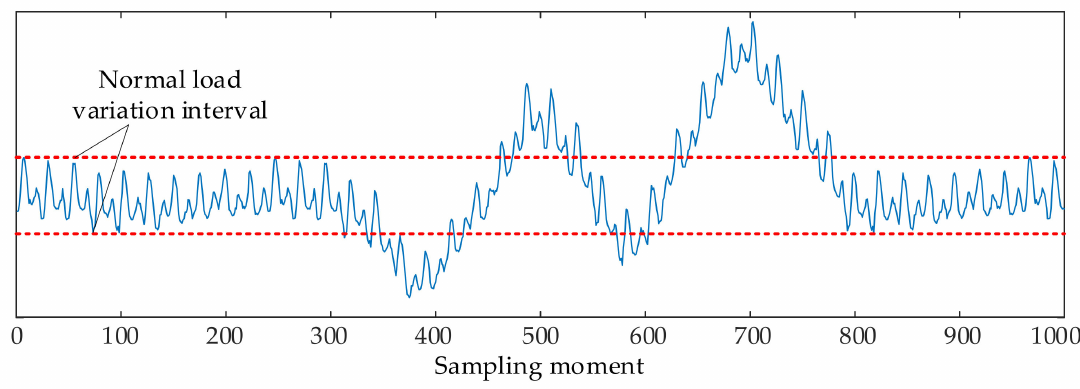
Figure 10. Load change